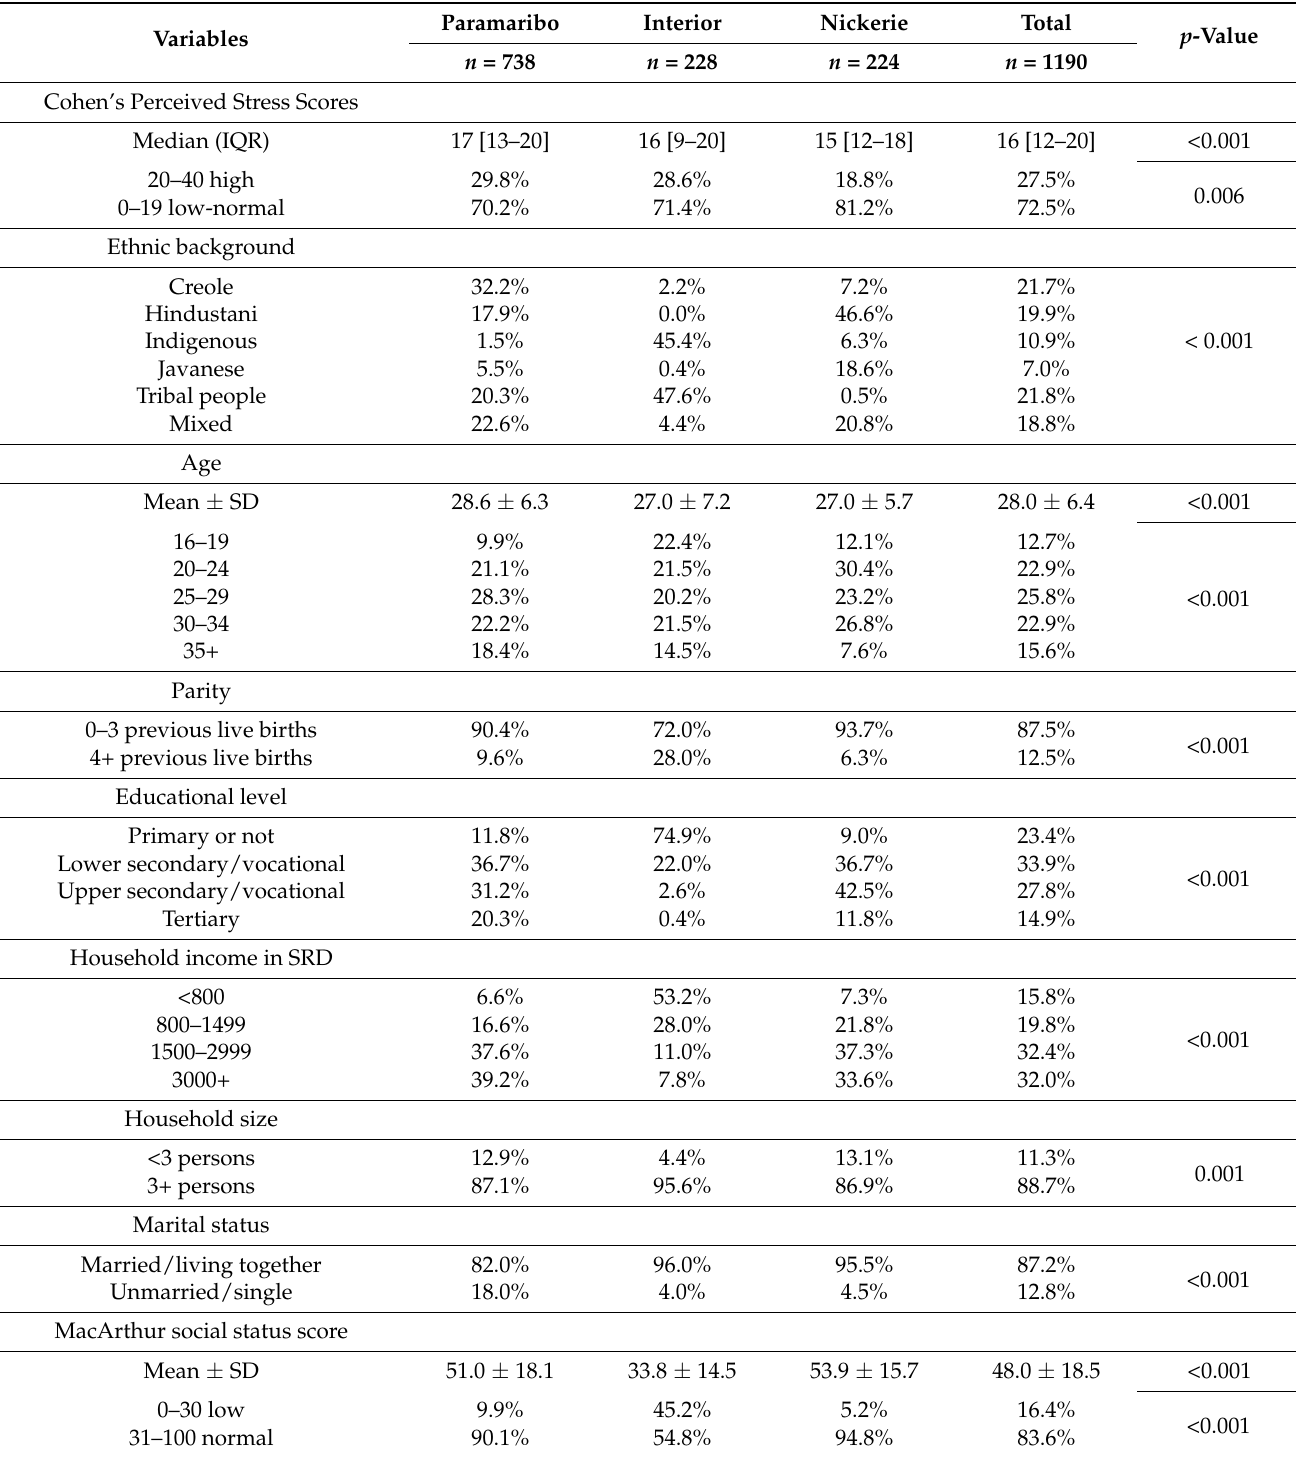
Table 1. The general characteristics of the CCREOH study population, stratified for geographic area ( n =